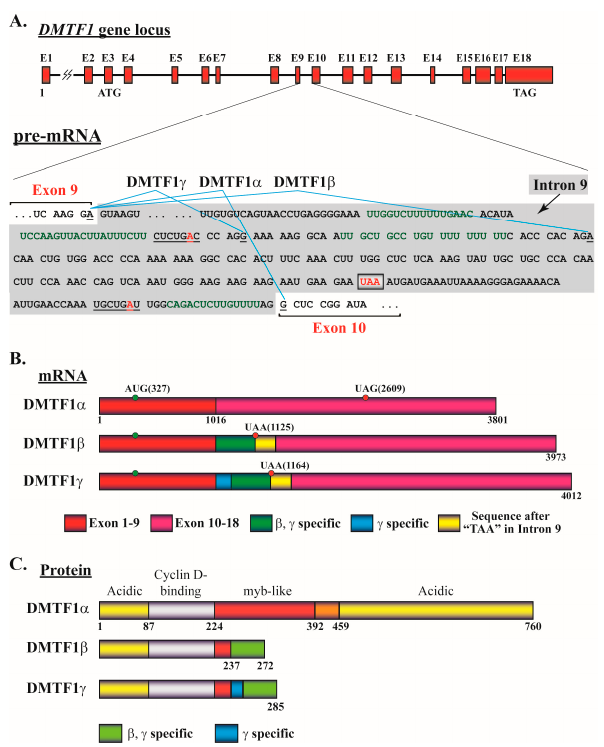
Figure 4. Schematic representation of the DMTF1 gene, alternatively spliced mRNA isoforms, and proteins. ( A ) DMTF1 gene arrangement and alternative splicing. The representation is based on the DMTF1 mRNA sequence of the accession number NM_001142327.1 in the NCBI. In the top panel, 18 exons of the DMTF1 gene are depicted by red boxes and the introns are represented by lines. The exons and introns are drawn approximately in proportion to their relative lengths, except intron 1 (about 11 KB, the omitted region is indicated by a lightening sign). The locations of the start codon ATG (in exon 3) and stop codon TAG (in exon 18, for DMTF1 α ) are indicated. In the lower panel, intron 9 is presented on a gray background, while the adjacent ends of exons 9 and 10 are indicated. The last nucleotide of exon 9 (underlined, right before the donor site, GU) alternatively ligates to the three nucleotides (underlined, right after the acceptor sites, AG) in intron 9 or exon 10, which is shown by blue lines to generate DMTF1 α , β , and γ isoforms. Parts of the sequence are presented as triplicates according to the reading frames of DMTF1 isoforms. The predicted consensus sites containing the “branch points” for DMTF1 β / γ and DMTF1 α splicing are underlined sequences CUCUGAC and UGCUGAU, respectively, with the branch points (adenosines) in red. The predicted polypyrimidine tracts for the three DMTF1 alternative splicing isoforms are in green. The stop codon TAA shared by DMTF1 β and γ isoforms is in red and boxed; ( B ) Transcripts of DMTF1 isoforms. The representations for the colored box are indicated at the lower panel and the nucleotide positions of the three DMTF1 transcripts are indicated beneath them. The start codon and the stop codons (UAG and UAA) are shown for each isoform with the numbers representing their positions in mature mRNAs; ( C ) Domain structures of DMTF1 protein isoforms. The domain structures are based on a previous report [66]. The amino acid positions and lengths of the three DMTF1 protein isoforms are indicated beneath them. The representations of the colored box for β / γ - and γ -specific regions are indicated in the lower panel.